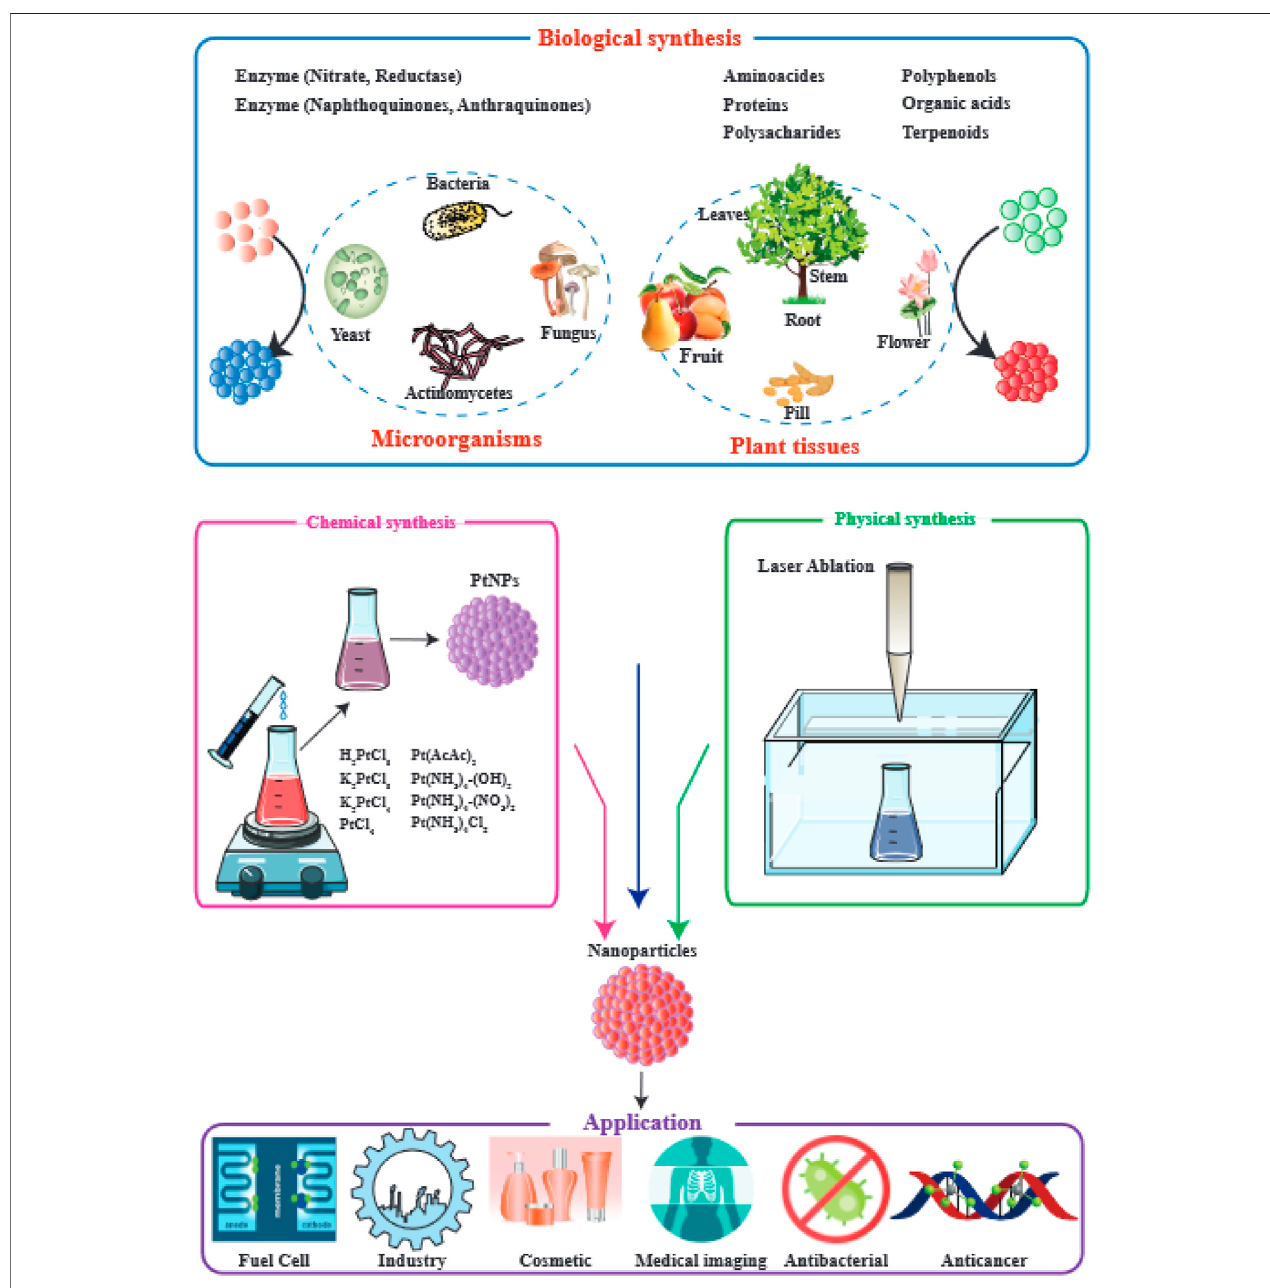
FIGURE 1 | Applications of PtNPs and their methods of preparation. This fi gure adapted from Jeyaraj et al. (2019).